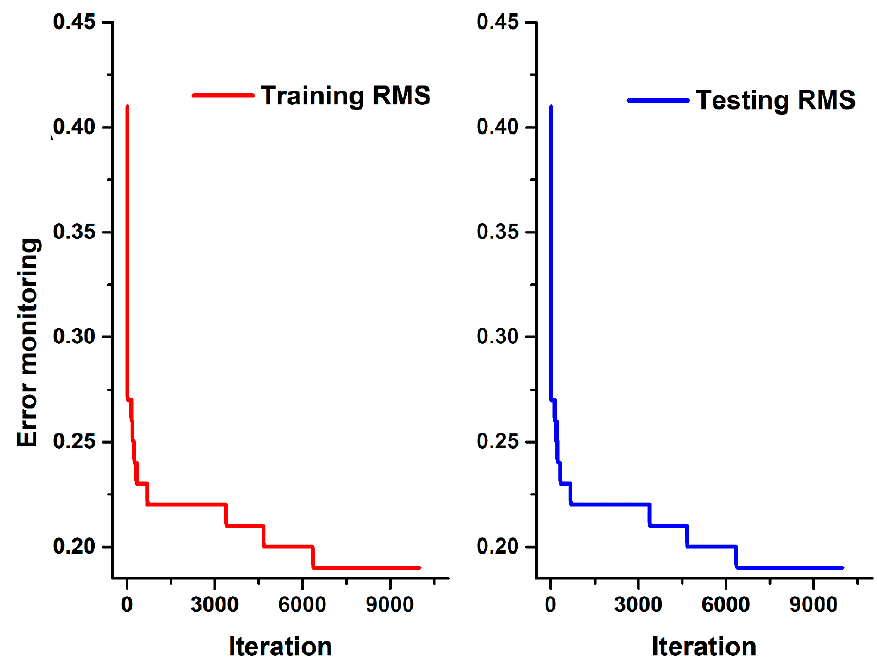
Figure 12. Error monitoring during the training and testing stages for LULCC prediction. Table 2. MLP running parameters and simulation results from TerrSet.